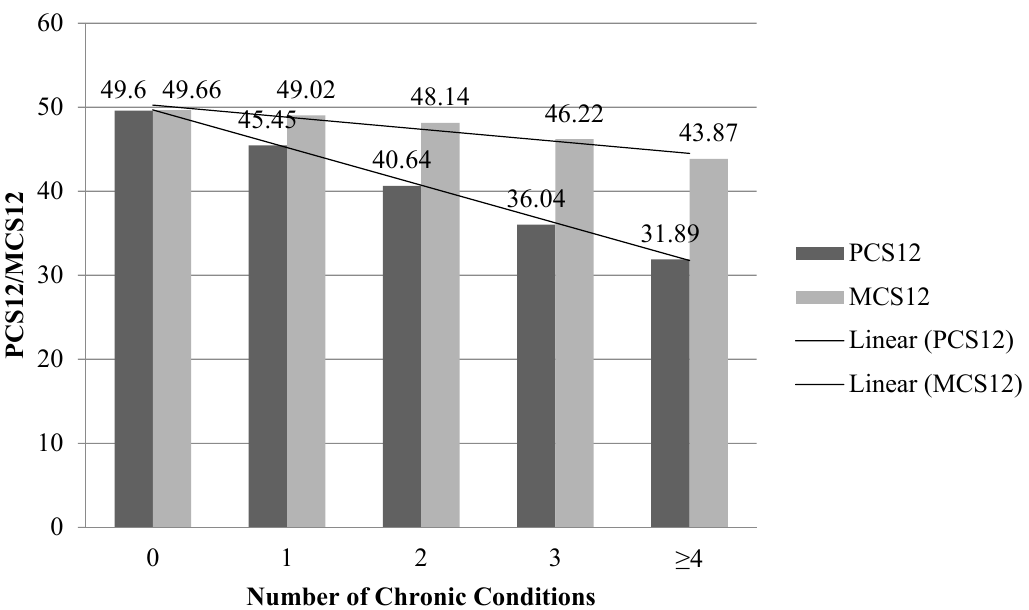
Figure 2. The SF-12 Physical and Mental Component Scores (PCS12 and MCS12) of the study sample, categorized by number of chronic conditions.